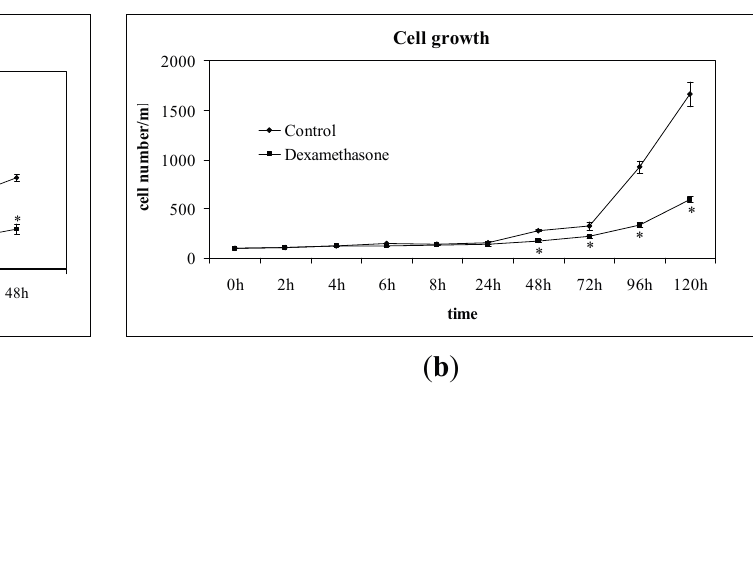
Figure 1. Effect of Dexamethasone on DNA synthesis and cell growth. ( a ) Incorporation of 3 H-thymidine in non-Hodgkin’s T cell human lymphoblastic lymphoma cell line (SUP-T1) cells. Cells were cultured for 48 h without (C = control sample) or with 100 Dex. 1 µCi 3 H-tymidine was added to the medium 2 h before the analysis. The radioactivity was evaluated on extracted nucleic acid in each preparation. The data are expressed as cpm/mg DNA and represent the mean ± S.D. of 3 independent experiments performed in duplicate. (Significance, * p < 0.001 versus 0 h); ( b ) Count of cell number. The data are expressed as cell number/mL and represent the mean ± S.D. of 3 independent experiments performed in duplicate. (Significance, * p < 0.001 versus control